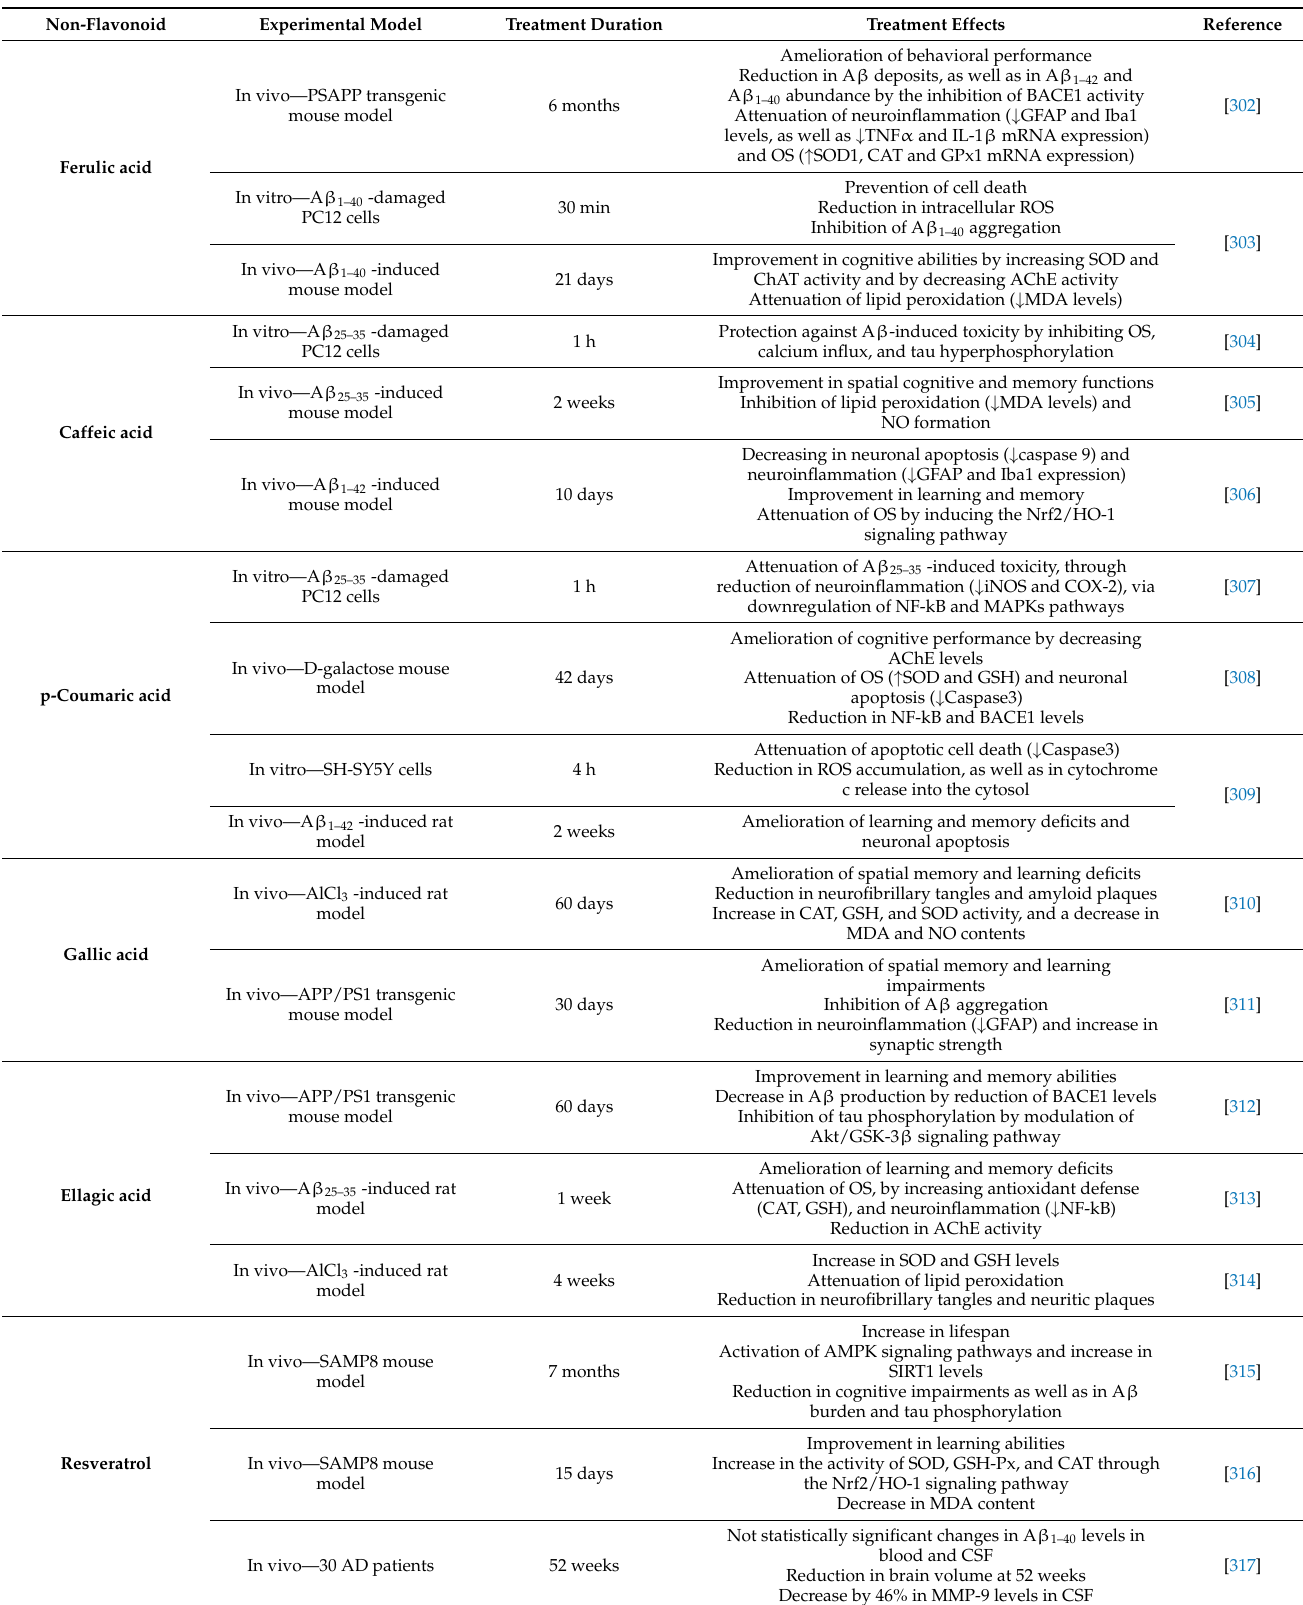
Table 1. Effects of non-flavonoid treatment in several experimental